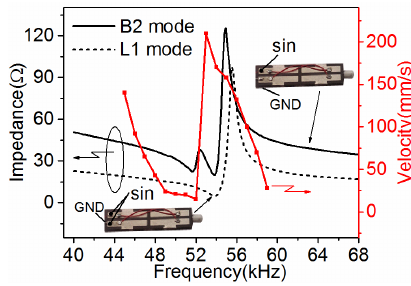
Figure 10. Impedance and velocity characteristic vs. frequency of the actuator.